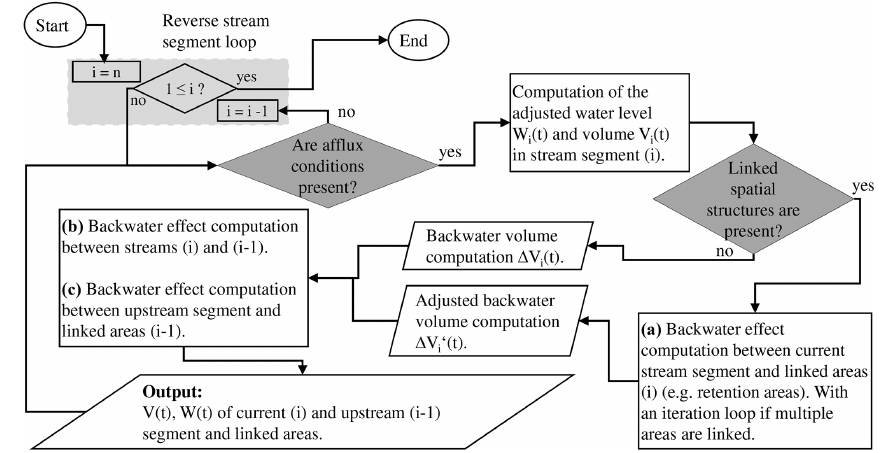
Figure 8. Computation of the upstream-directed backwater effect over stream segments and adjacent lowland areas (e.g. retention areas). Details are illustrated in Fig. 5 in the algorithm (b).